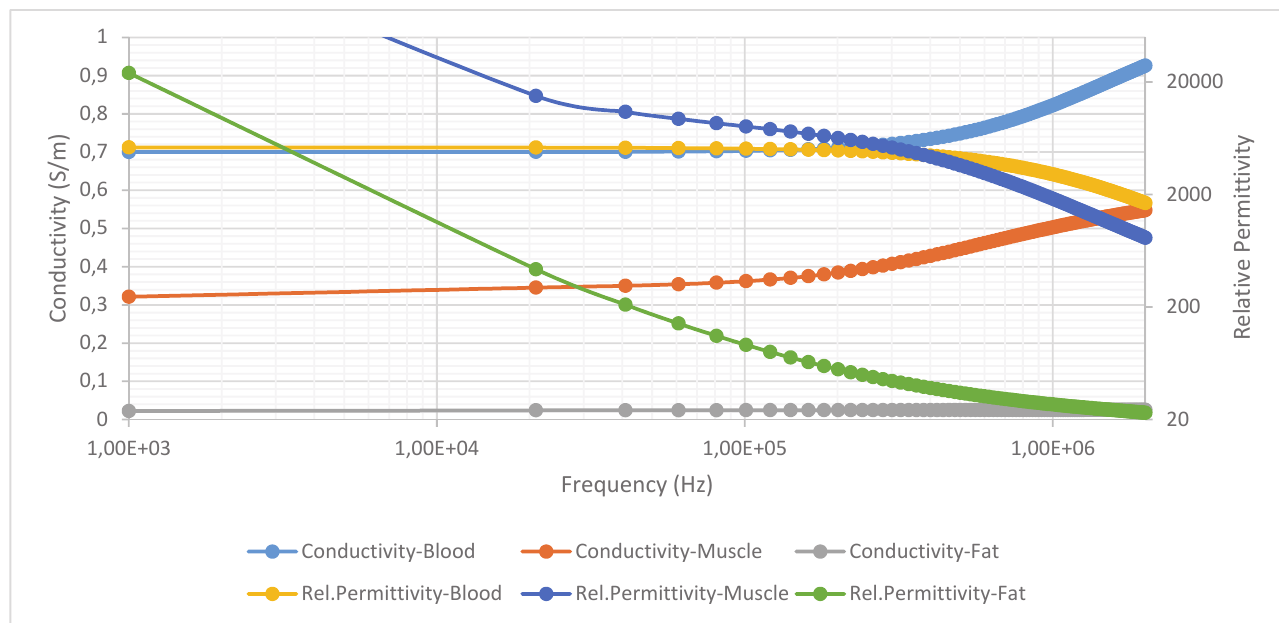
Fig. 2: Conductivity and permittivity values for blood, muscle and fat used in the simulation as compiled by Gabriel